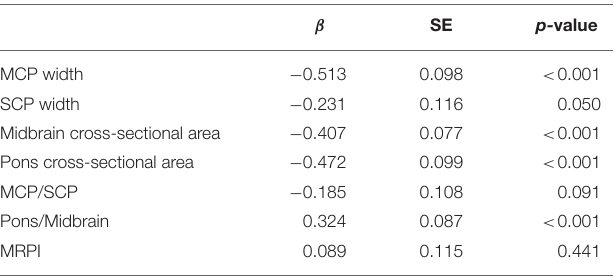
TABLE 3 | Relationships between MRPI measurements/ratios and the FXTAS stage scale for all premutation carriers with and without FXTAS.